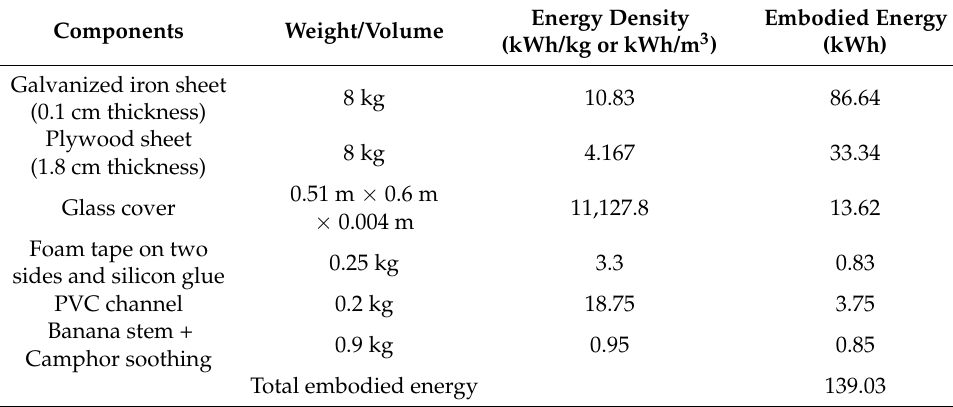
Table 5. The MSS’s overall embodied energy.